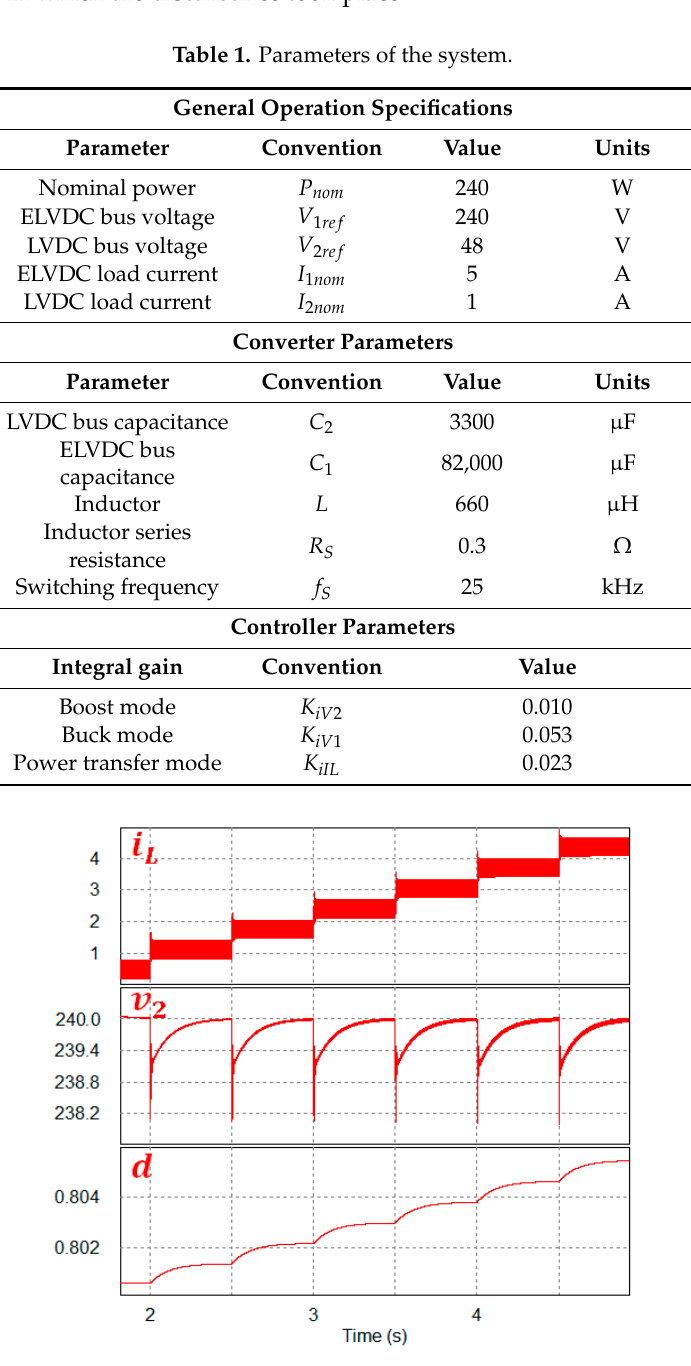
Table 1. Parameters of the system.